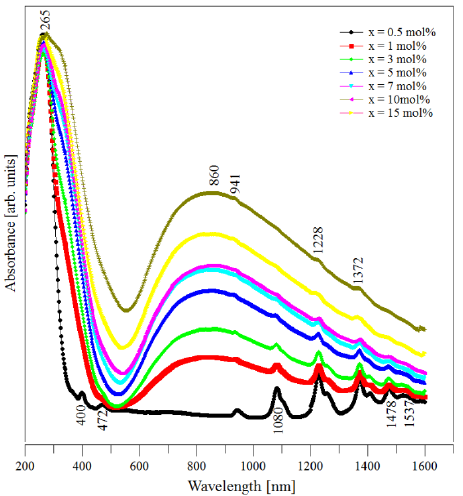
Figure 4. UV–Vis absorption spectra of the (CuNPs) x · (P 2 O 5 ) 35 · (Sb 2 O 3 ) (64 − x) · (Sm 2 O 3 ) 1